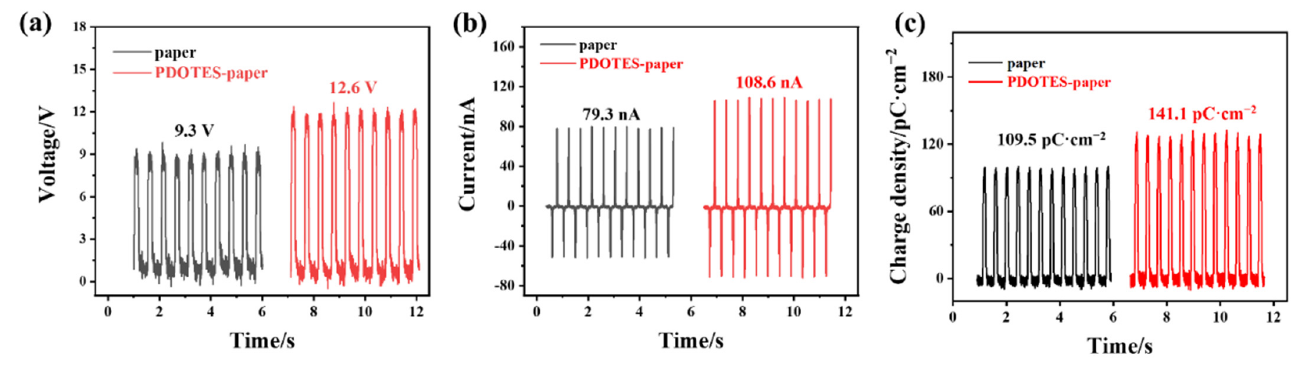
Figure 9. Output performance of paper-based TENG before and after cellulose modification: ( a ) Open circuit voltage; ( b ) short circuit current; ( c ) charge density.